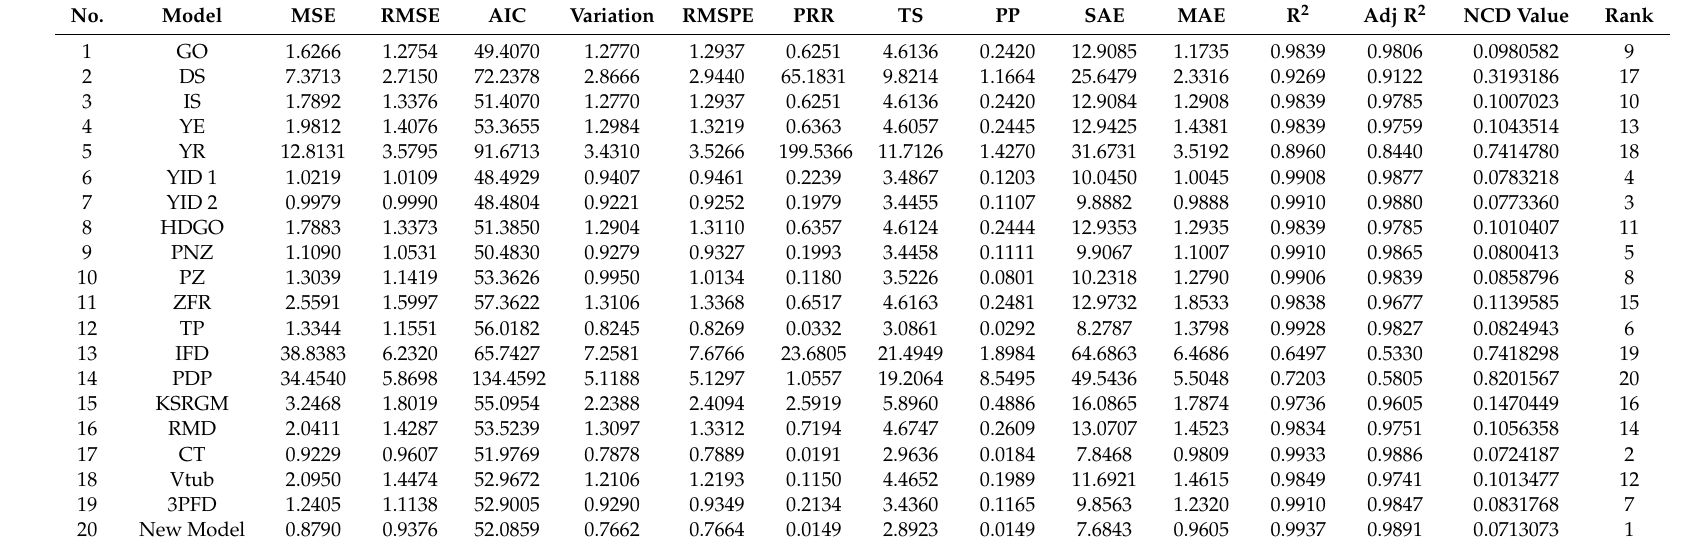
Table 8. Results for criteria and NCD value for comparison with dataset